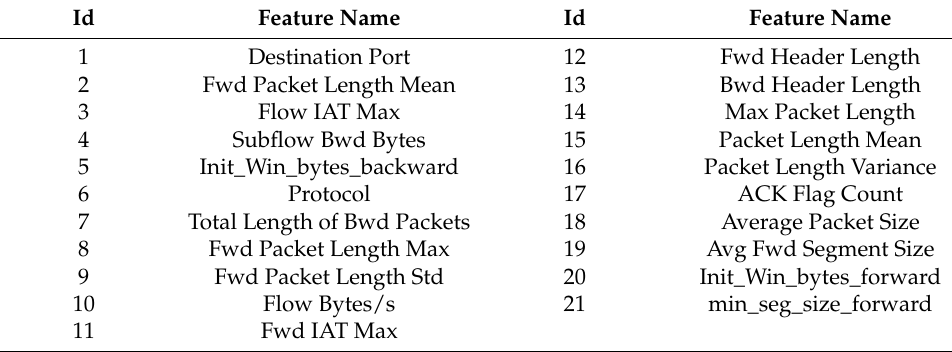
Table 3. Feature selection algorithm processing results.